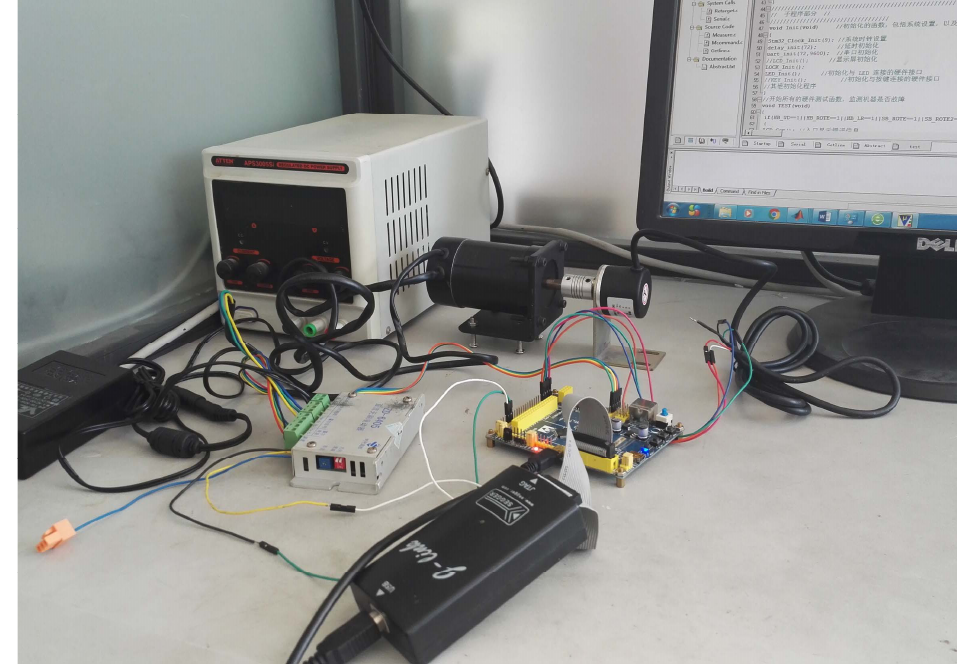
Figure 4. The test bed of the